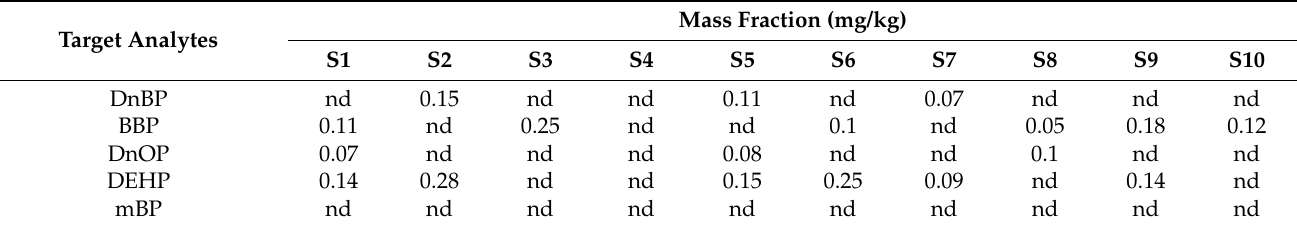
Table 4. Analysis of commercial rice